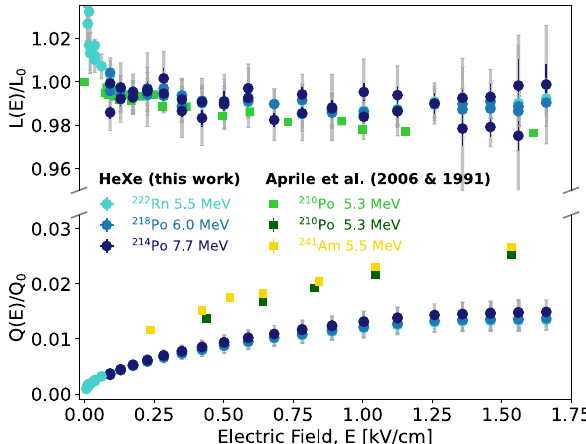
Fig. 18 Light and charge yields for the α -decays of 222 Rn, 218 Po, and 214 Po as function of electric field. The data is compared with the results from [12,13]. Gray bars indicate the systematic error. Data points are provided online [32]